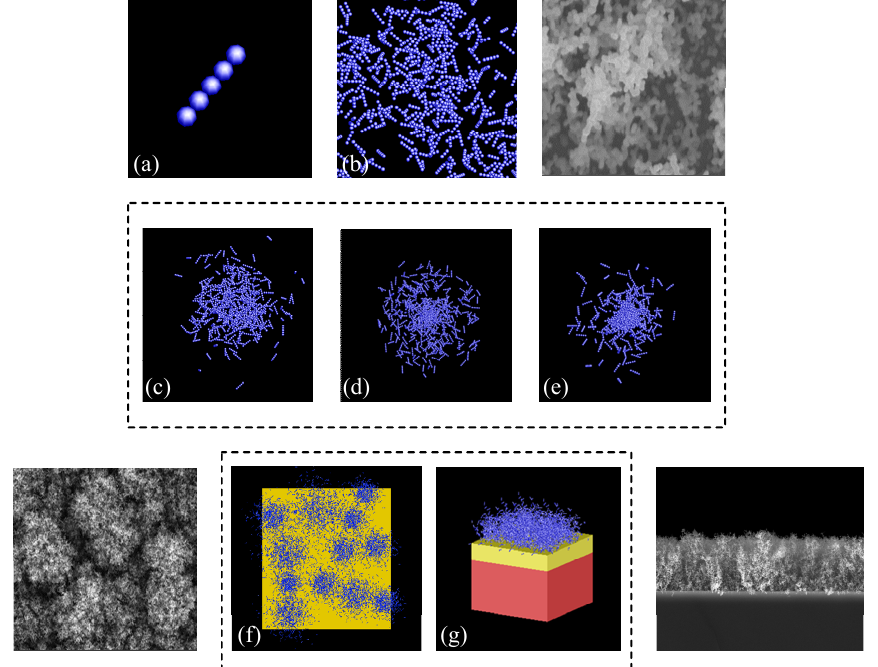
Figure 4. Modeling of nanochain aggregate structure. ( a ) Basic nanochain structure. ( b ) Nanochains with random three-dimensional orientations. ( c ) Cluster based on Gaussian distribution. ( d ) Cluster based on uniform distribution. ( e ) Cluster based on Cauchy distribution. ( f ) Top view of physical model. ( g ) Sectional view of physical model.